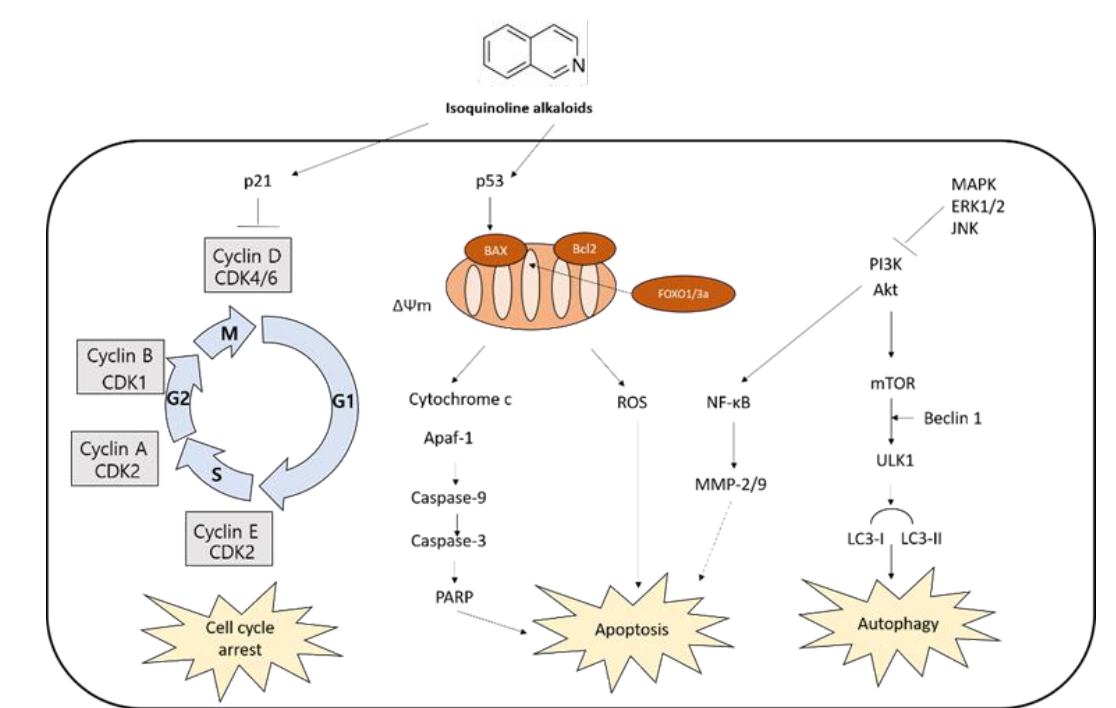
Figure 3. Molecular pathways involved in anticancer